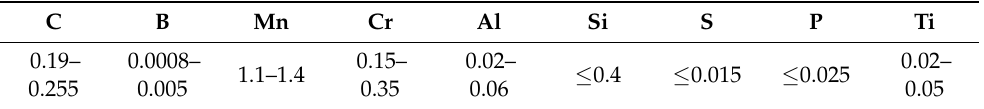
Table 1. Chemical composition of B1500HS steel (wt.%).